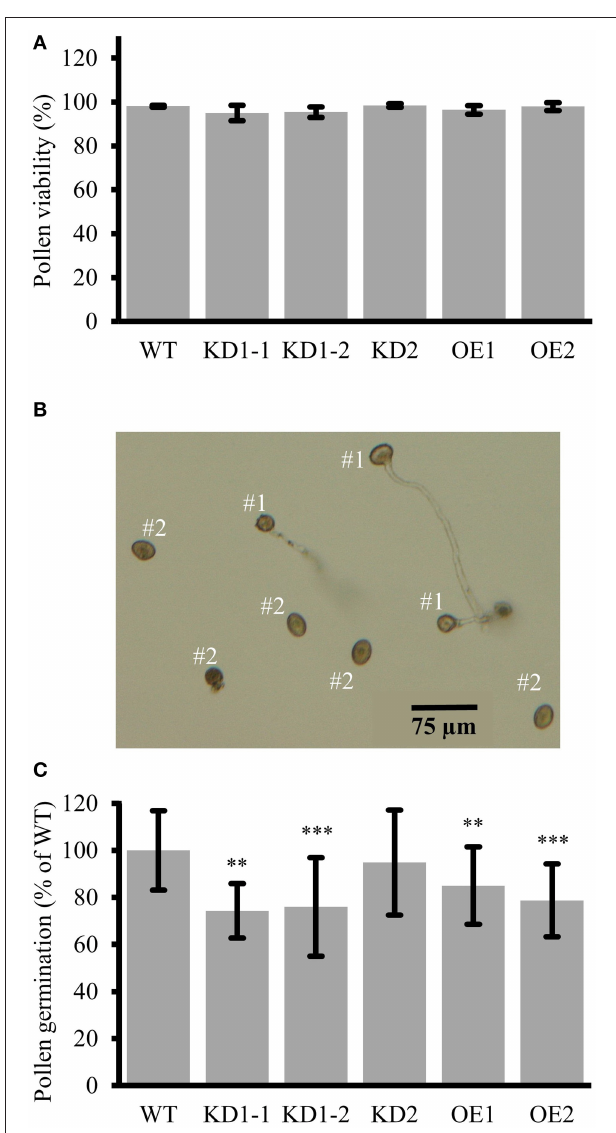
FIGURE 10 | Reduced pollen germination in COX11 KD and OE mutants. (A) Pollen viability in COX11 mutants compared with the WT. Error bars represent ± SD of means from four experiments. Between 400 and 600 pollen grains per plant line were evaluated (B) Definition of germinated (#1) vs. non-germinated (#2) pollen grains used for determining germination rates. (C) Pollen germination rates of KD and OE mutants were normalized to the WT ( = 100%). Error bars represent ± SD of means from 10 experiments. For each experiment, germination of 100–300 pollen grains was evaluated in duplicates or triplicates. Asterisks indicate statistical significance calculated with the Student’s t -test ( ** P < 0.01 ; *** P < 0.001 ). Exact values are given in Supplementary Table